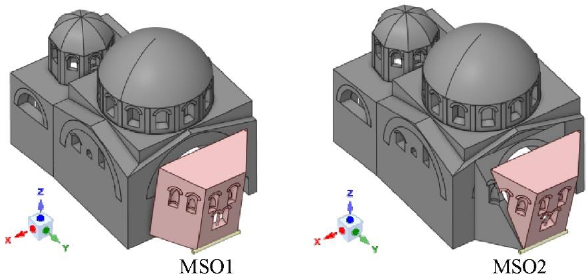
Figure 25. Failure mechanisms of main structure. Table 4. Failure mechanisms and results of the kinematic limit analysis. Mechanisms